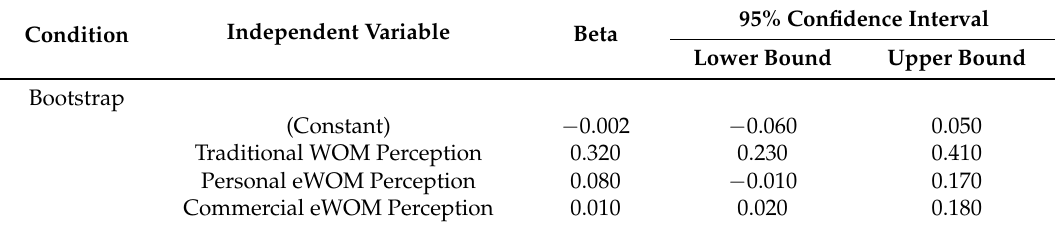
Table 4. Confidence intervals for Traditional WOM and Personal and Commercial eWOM Perceptions.